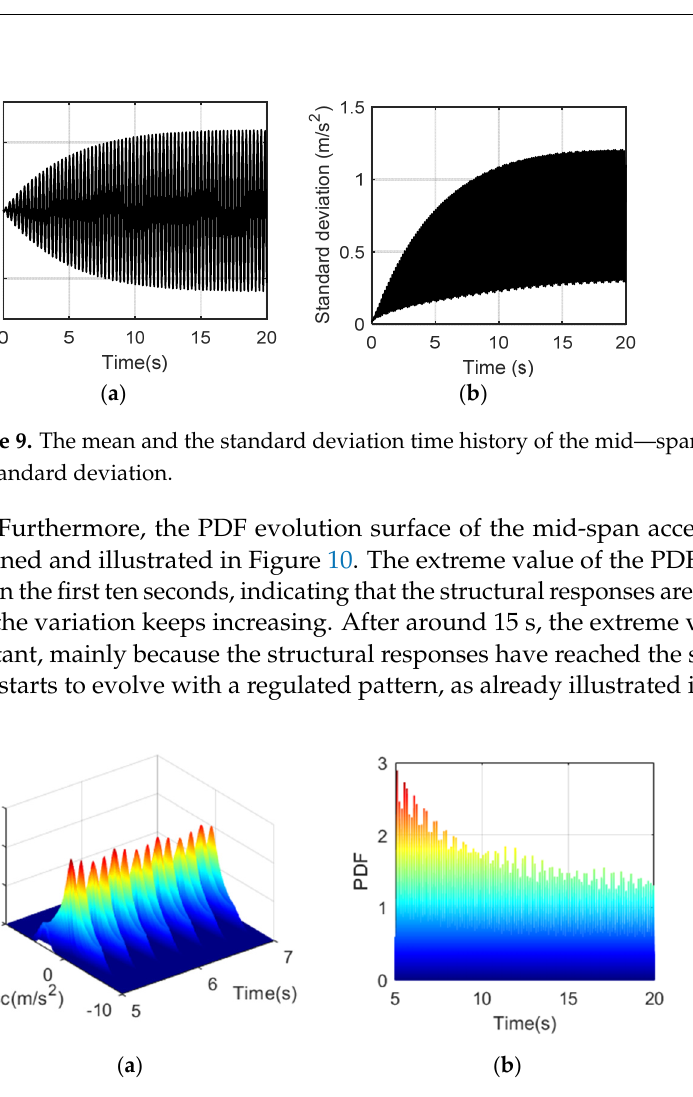
Figure 10. Probability density evolution surface of the structural mid-span acceleration: ( a ) Azimuth = − 37.5° and elevation = 37.5°; ( b ) Azimuth = 0 and elevation = 0.